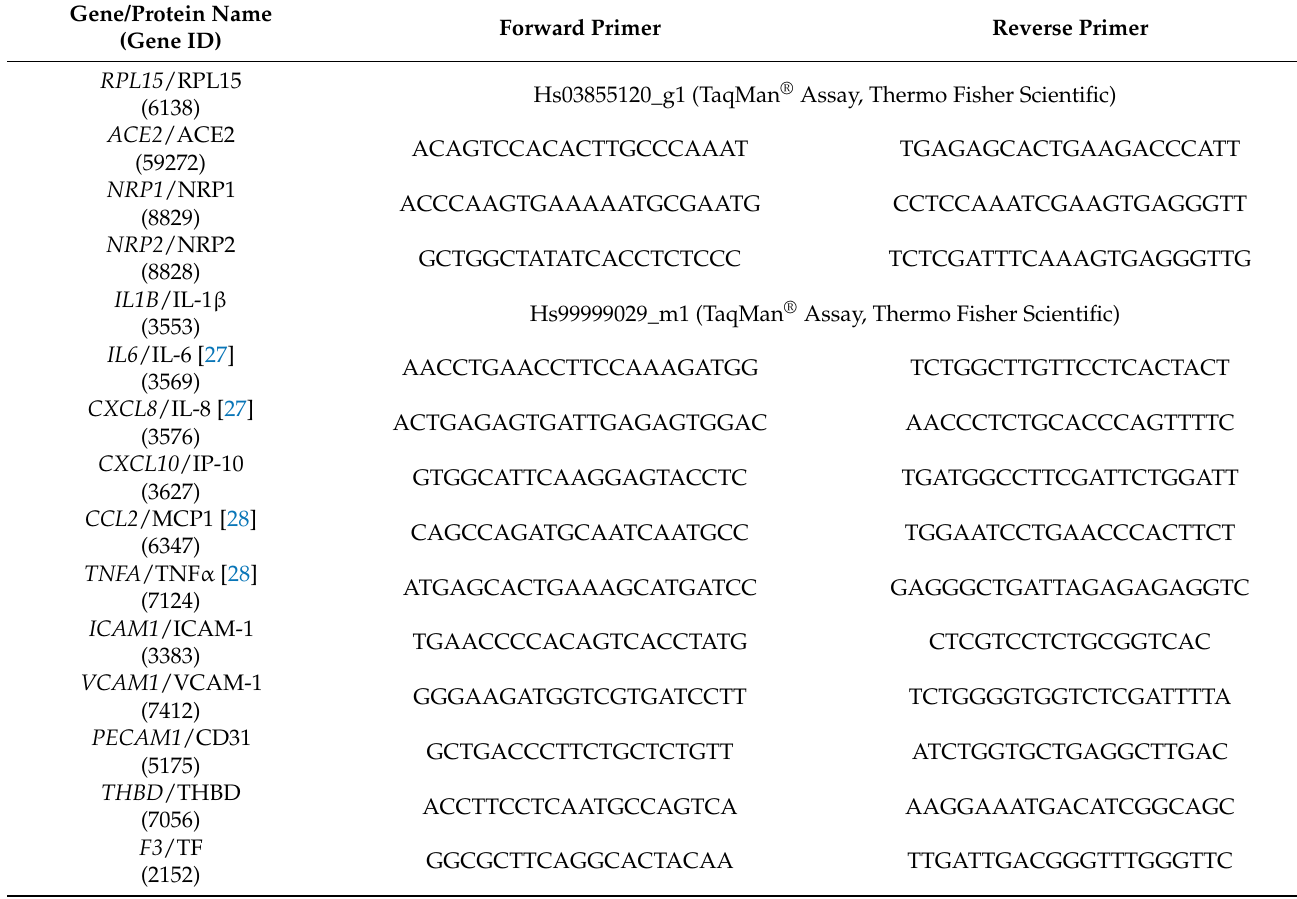
Table 1. Sequence of primer pairs employed for RT-qPCR